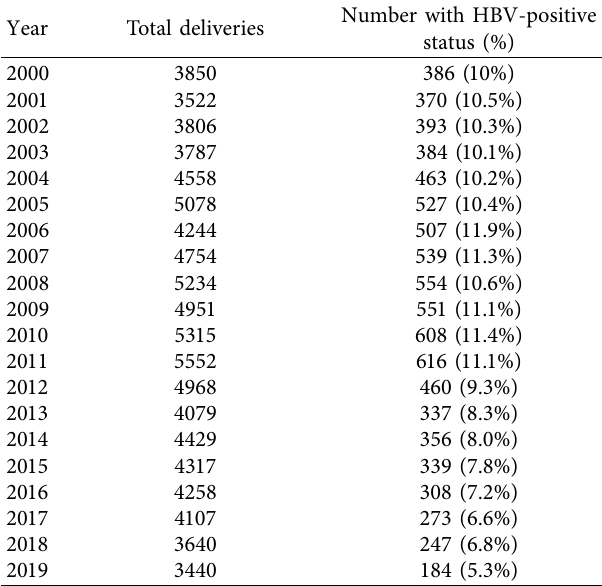
Table 1: Prevalence of hepatitis B surface antigen carrier status,